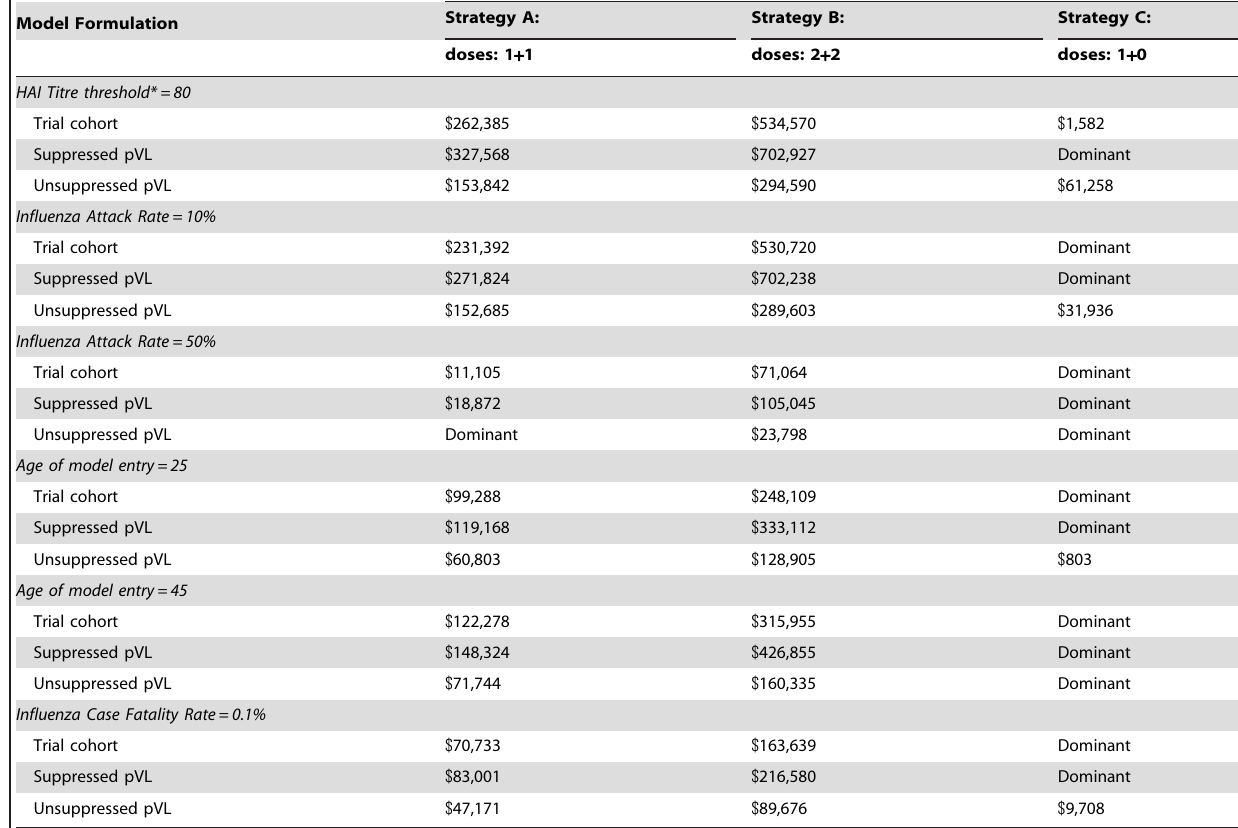
ICER vs. Strategy D: standard of care [2009 $ CDN]